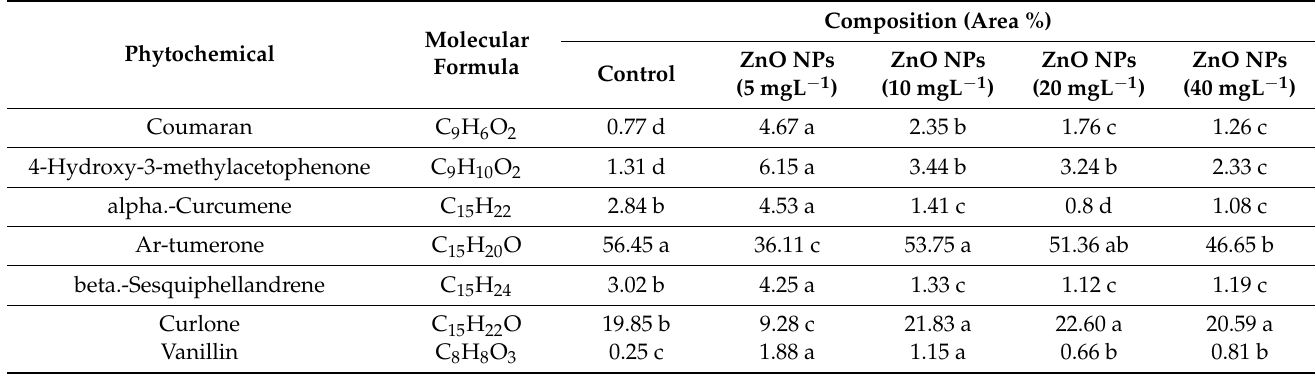
Table 6. Comparison of the compositions of common compounds in the ethanolic rhizome extracts from C. longa plants of various experimental groups. Ethanolic extracts from three plants were measured to obtain the average value as presented. Mean values followed by the same letter within a column are not significantly different at p = 0.05, as measured by Duncan’s